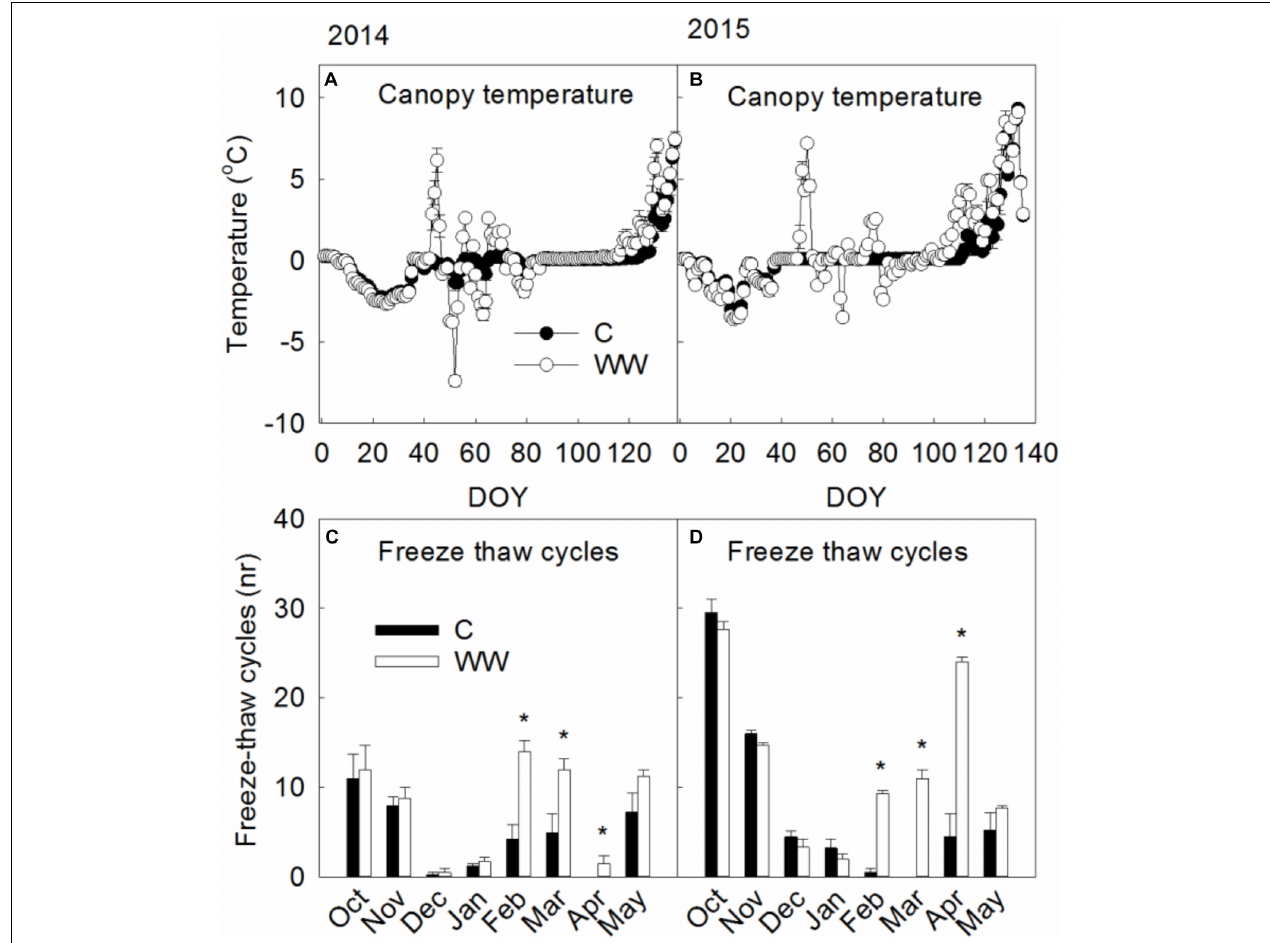
FIGURE 1 | (A,B) Show canopy temperatures measured during 2014 and 2015 respectively in control plots (C) and those exposed to extreme winter warming (WW). (C,D) Show the monthly number of freeze-thaw cycles during 2014 and 2015 respectively. Mean daily canopy temperatures and monthly number of freeze thaw cycles during the winters of 2014 and 2015. Data points and bars are means of n = 4 with SE as error bars. ∗ indicate significant ( P < 0.05) differences between treatments. Canopy temperatures were measured following the extreme winter warming event of 2016 but not during the winter period before therefore, these are not